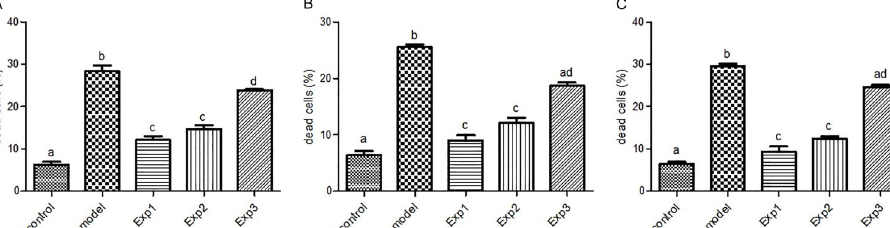
Figure 9. Quantitative analysis of Figure 8 data. Control group represents healthy neurons, model group represents neuronal damage, and treated groups represent mild neuronal injury. In all groups, data were obtained from 5 different animal specimens with 5 random slides and are reported as means ± SE. Different letters indicate a statistically signi fi cant difference (ANOVA). A , Rate of cell death in the presence and absence of trans- chalcone in the dentate gyrus region, ( B ) in the presence and absence of silibinin in the dentate gyrus region, and ( C ) in the presence and absence of silibinin in the cornu ammonis region. See Table 1 for group description.